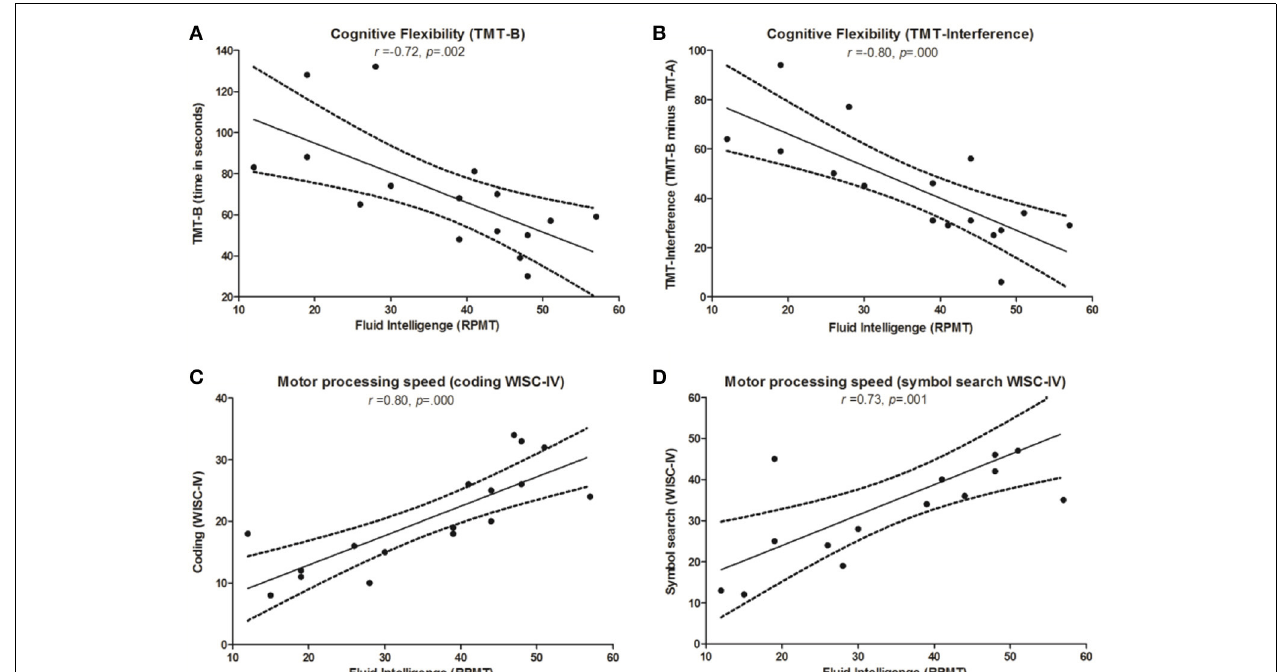
FIGURE 3 | Correlations between FI and cognitive tasks in AS children. Significant correlations in the AS group between Raven’s Progressive Matrices Task (RPMT) and: (A) Trail-Making Test part B (TMT-B); (B) Trail-Making Test,